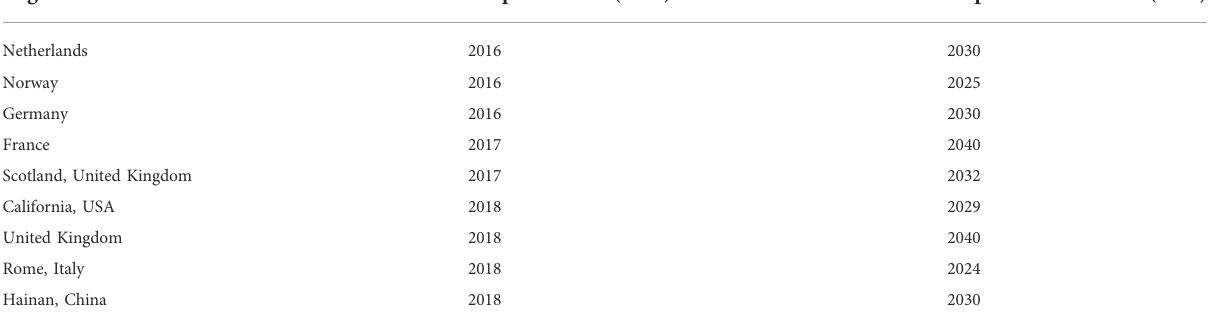
TABLE 2 Timeline for countries to ban the sales of